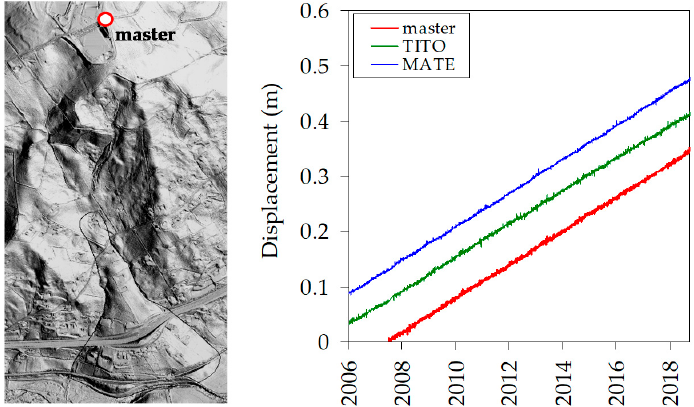
Figure 8. Displacement time series in the IGS14 coordinate system of the master station and two other permanent stations located in the same sector of the Southern Italian Apennines: MATE (operated by ASI—Italian Space Agency) and TITO (operated by CNR—National Research Council of Italy).